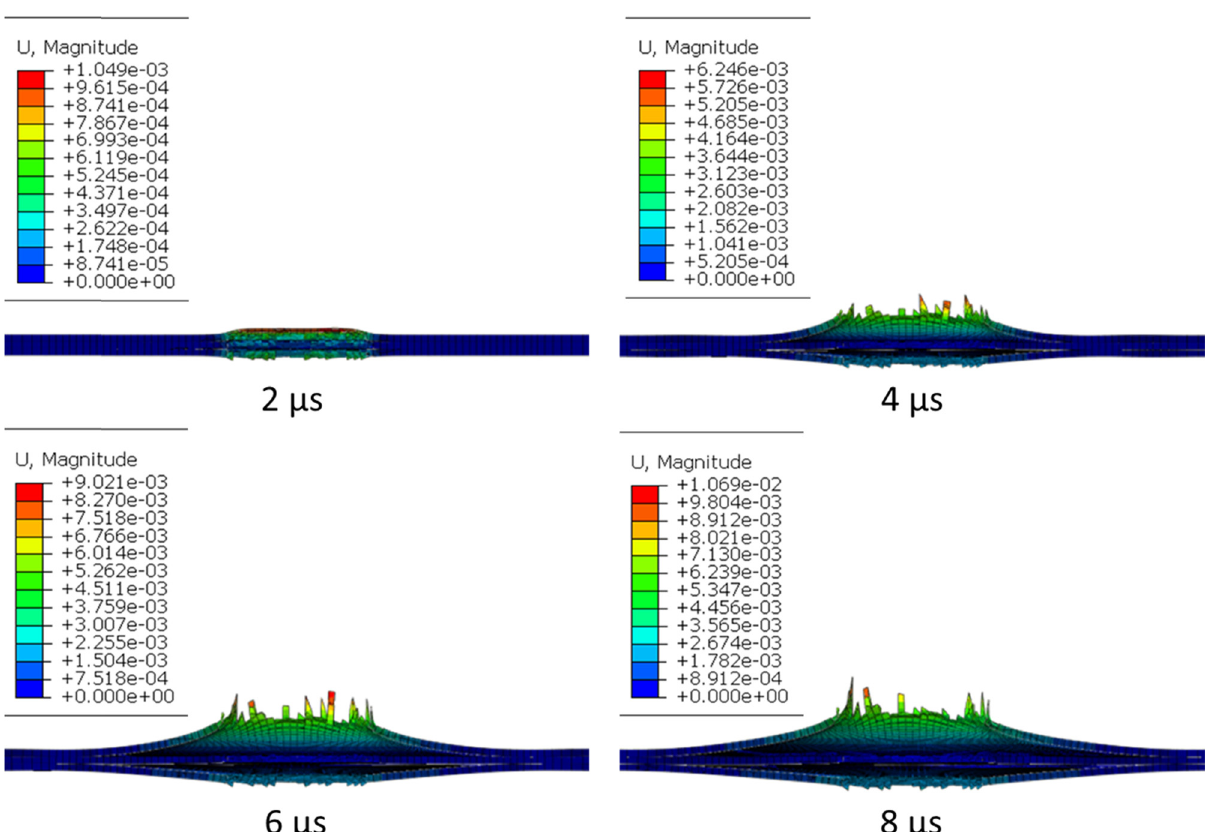
Figure 20: Displacement for model 7 against blunt